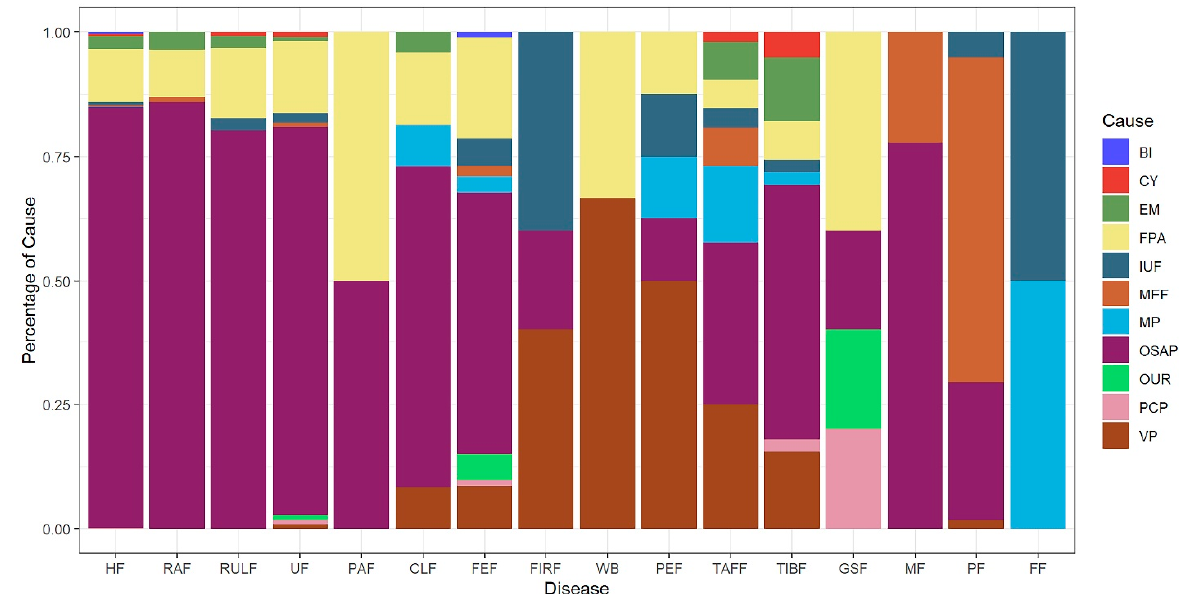
Figure 7. The proportion of causes in types of fracture in children. Legend: OSAP mainly lead to PAF (patella fracture), CLF (clavicle fracture), FEF (femur fracture), TIBF (tibial fracture), MF (met- acarpal fracture), and fractures of upper limbs referring to HF (humerus fracture), UF (ulna frac- ture), RAF (radius fracture), and RULF (fracture of radius and ulna), while FPA (falling from one plane to another) placed second, especially GSF (40.0%). VP (vehicle passenger injury) contributed to most of the fractures in lower limbs, including FIRF (fibula fracture), PEF (pelvic fracture), TAFF (fibula fracture), and TIBF and whole body (WB). VP and FPA primarily caused a severe fracture of the whole body (WB). MEF (mechanical force) was related to distal limbs: MF and PF (phalanx frac- ture). IUF (improper use of force) resulted in FIRF and FF (foot fracture), while the other reason causing FF was MP (motorcycle passenger injury). MP led to CLF, PEF, and TAFF. For lower limb fractures, TAFF and TIBF resulted from the greatest variety of causes, including CY (cyclist injury), EM (exercise machine injury), FPA, IUF, OSAP, PCP (physical contact with people), and VP. PCP (physical contact with people) mainly resulted in GSF (growing skull fracture) and TIBF. Table 2. The proportion of causes of injury in types of fractured children.